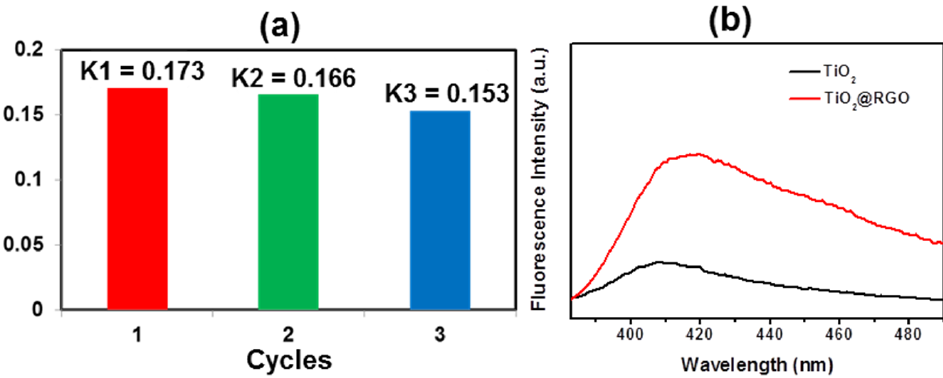
Figure 6. ( a ) The apparent first-order rate constant k versus times for TiO 2 @GO. ( b ) Fluorescence spectra of the visible light irradiated TiO 2 and TiO 2 @GO.